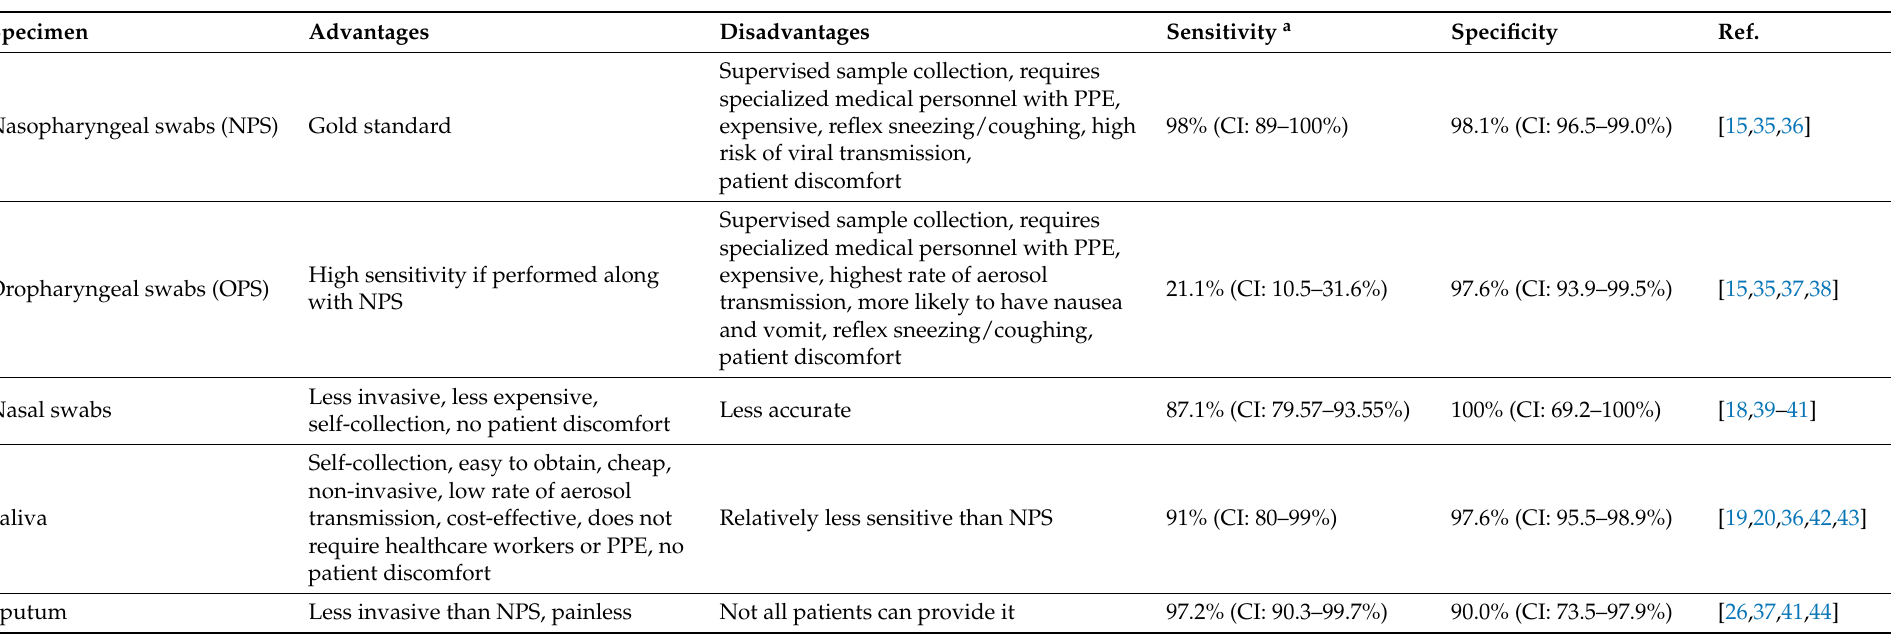
Table 1. Characteristics of different sampling methods for diagnosis of